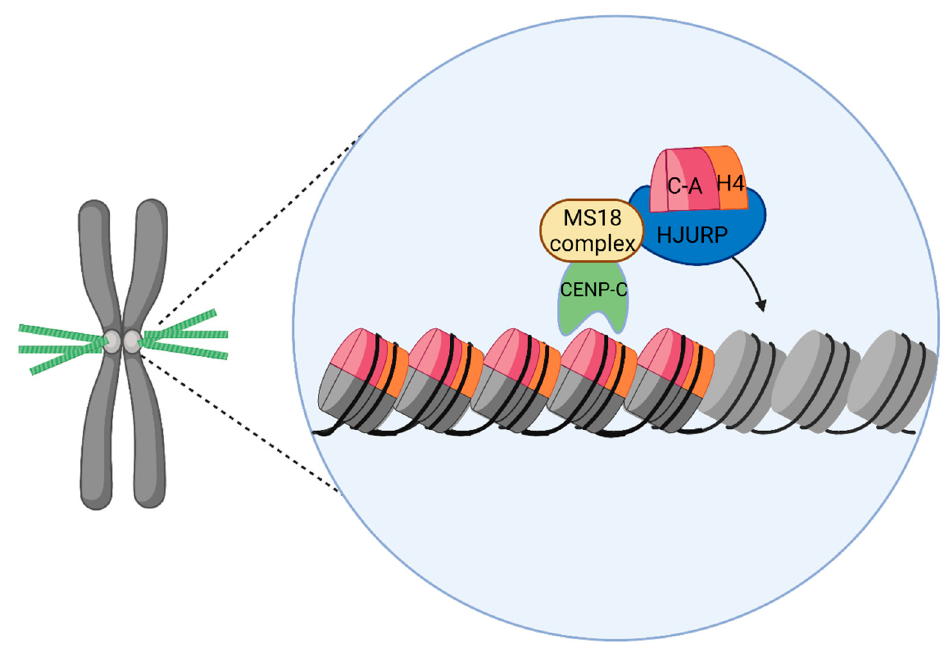
Figure 5. The recruitment of CENP-A to centromeres. The Mis18 complex binds to CENP-C, preceding HJURP to centromeres. HJURP then chaperones CENP-A to centromeric chromatin for deposition into nucleosomes.